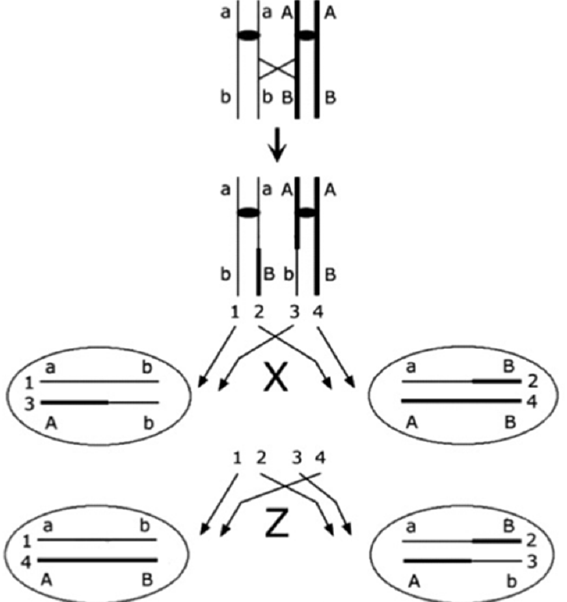
Figure 1. A schematic representation of mitosis with crossing over. Each segment represents a chromatid, with sister chromatids linked by a centromere (black oval); crossing over (diagonal cross) occurs between the centromere and locus B. Two types of segregation are possible (Stern [51]): z segregation, in which the two recombinant chromatids (2 and 3) segregate together, apart from the two non-recombinant chromatids (1 and 4); and x segregation, in which each recombinant chromatid segregates with the non-sister non-recombinant chromatid. Loss of heterozygosity occurs for all loci distal to the site of crossing over with x segregation (in this example, at locus B).